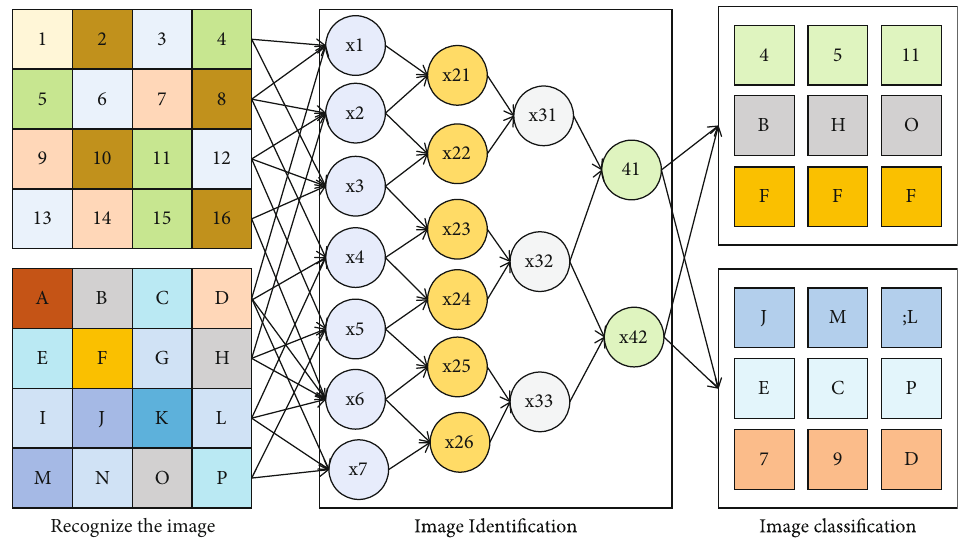
Figure 1: Full connection implementation